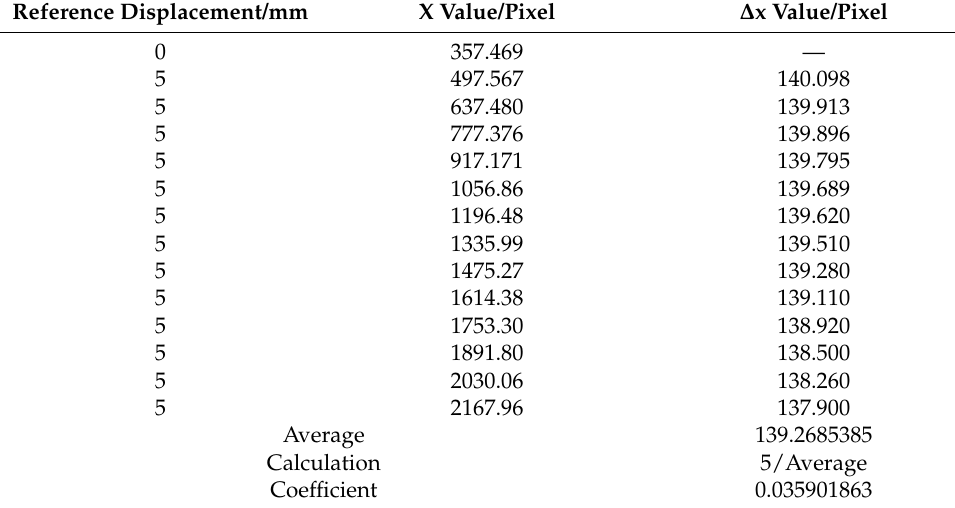
Figure 14. (a) Schematic diagram of the experiment. (b) Procedure picture of the experiment. Figure 14. ( a ) Schematic diagram of the experiment. ( b ) Procedure picture of the experiment. The experiment data are shown in Table 1. The experiment data are shown in Table 1. Table 1. Experiment Table 1. Experiment data.